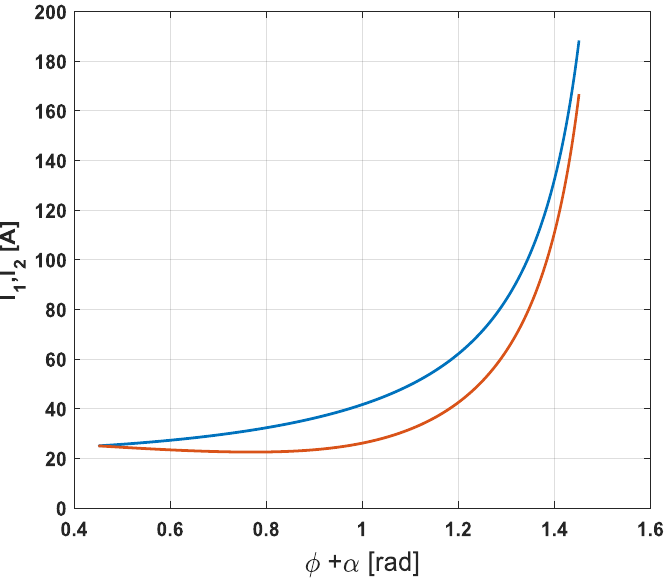
Figure 5. The dependence of apparent currents I 1 and I 2 of the generators on the phase shift between the current of the first generator and the load voltage ( ϕ + α ) The values of the load angles δ 1 , δ 2 and emf of the generators E 1 , E 2 were determined on the basis of Equation (3) and the vector diagram (Figure 3b).